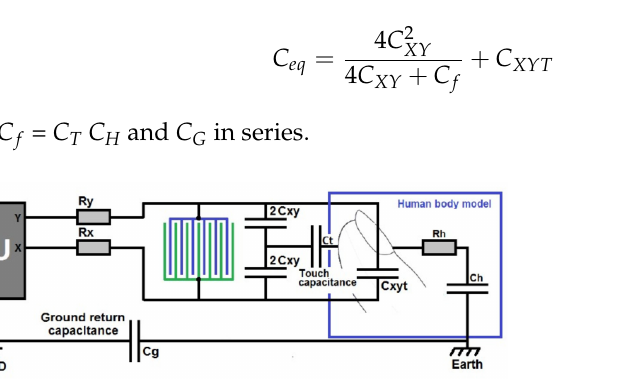
Figure 5. Circuit equivalence of a mutual capacitive touch sensor with an approaching finger [78].